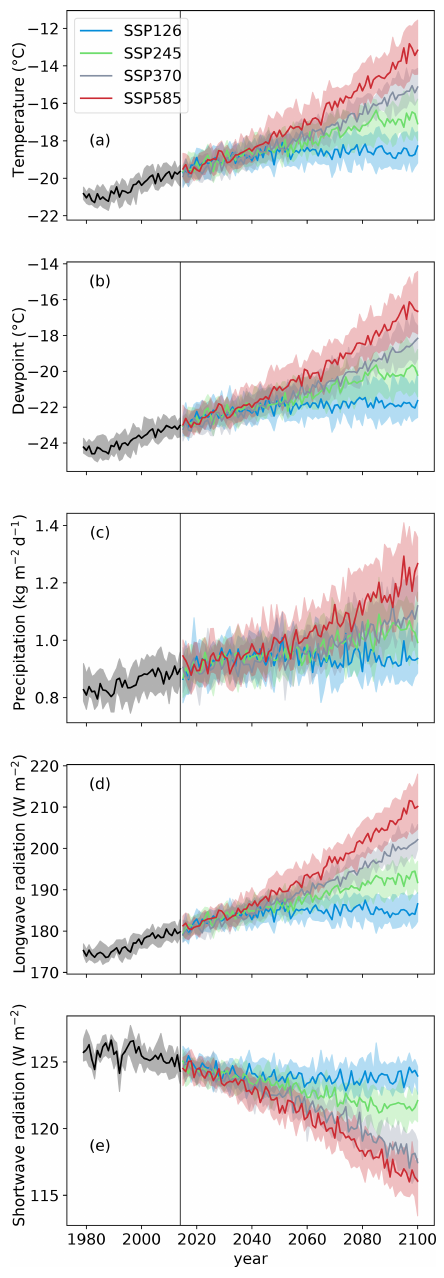
Figure 1. Input variables for BESSI, which are interpolated and bias-corrected ESM data, for different scenarios, averaged over the Greenland ice sheet. The solid line is the median over all ESMs for one scenario, and the shaded area between the 25% and 75% per- centiles represents half of the ESMs. (a) Temperature at 2m above ground. (b) Dew point at 2m above ground. (c) Amount of pre- cipitation. (d) Surface downwelling longwave radiation. (e) Sur- face downwelling shortwave radiation. The vertical line indicates the boundary between the common time period of the historical ESM simulations and ERA-Interim (1979–2014) and the future pro- jection time period (from 2015). Please note that the precipitation unit, 1kgm − 2 d − 1 , equals 1mm (w.e.) per day; w.e. stands for wa- ter